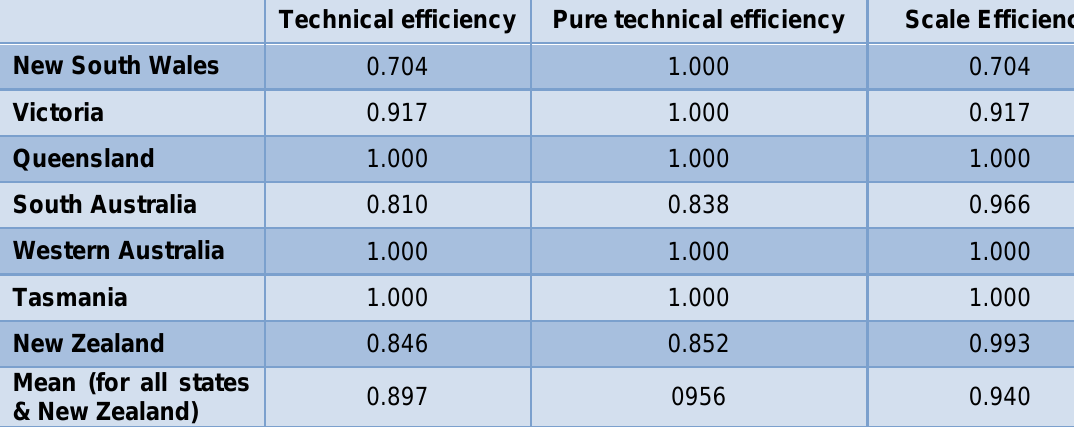
Table 5 Efficiency levels 1991-2010 Australian and New Zealand jurisdictions (output=residential floor area & value added; inputs=labour & capital